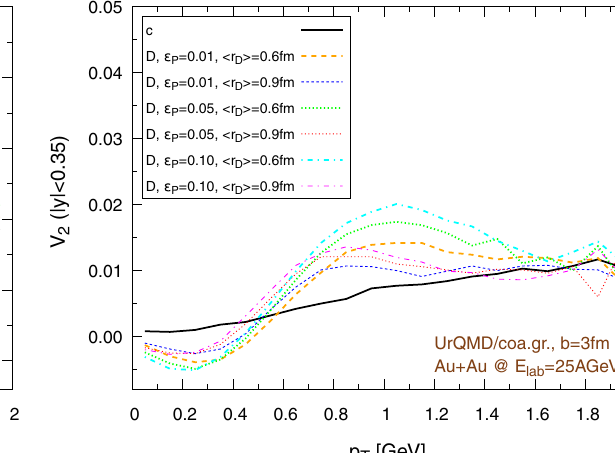
thehadronizationparameters,byperformingasinglehadronizationpro- cess,withoutfurtherhadronicpropagationinthemedium.Left: ¯ c quarks and ¯ D mesons, right: c quarks and D